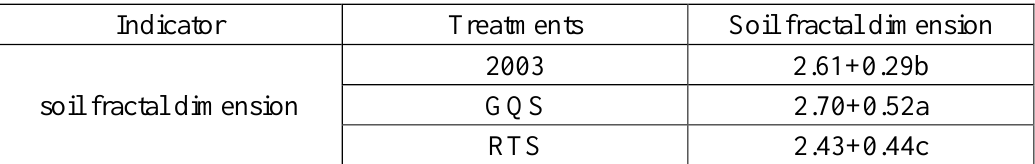
Table A1.2. The soil fractal dimension 2003 at 0-10 cm in depth of summer pasture at baseline, and under the community quota system (GQS) and rangeland transfer system (RTS) in 2014 (n=9). Note: Different lowercase indicated that there was significant difference among 2003, GQS and RTS at the level of 0.05, and vice